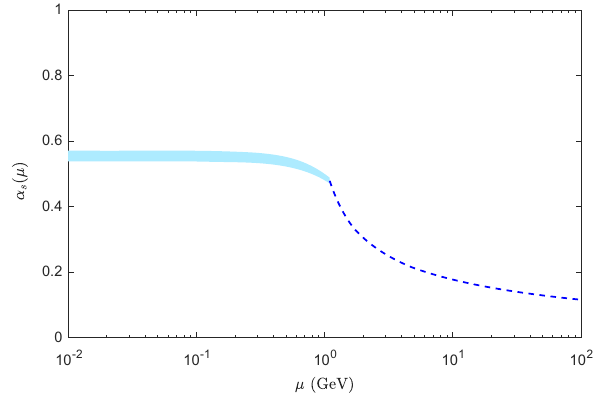
Fig. 1 The strong coupling constant α s within different energy scales. In low-energy region, the shaded band is for CON-model with m g ∈ [ 650–700 ] MeV. In large-energy region, the conventional MS α s run- = 0 . 383 GeV ning behavior is adopted. (cid:12) | n f = 3